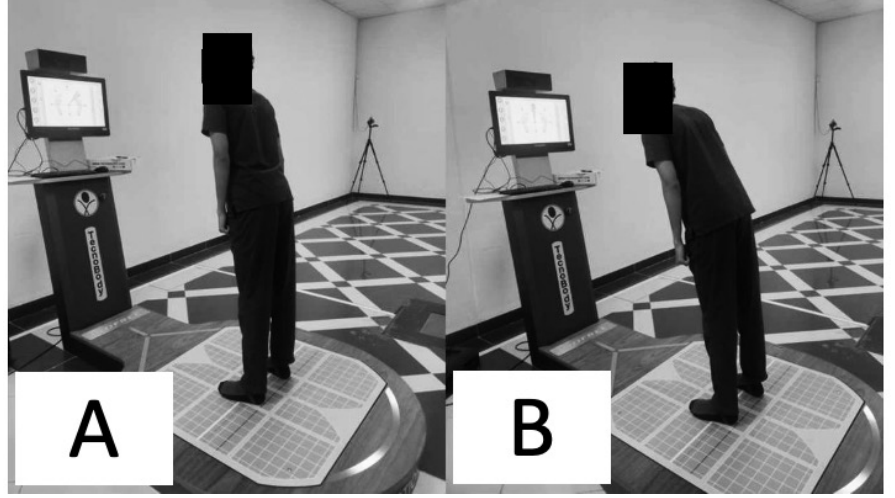
Figure 3. Limits of stability assessment ( A ) at the start and ( B ) when moving to a target. The instrument recorded and provided a score for the amount of sway needed to reach the target from the center along the exact shortest vertical or horizontal path. One hundred was the maximum score that could be obtained in a direction. A lower score indicated greater sway. The limits of stability parameters included were reaction time, maximum excursion, and directional control [35].